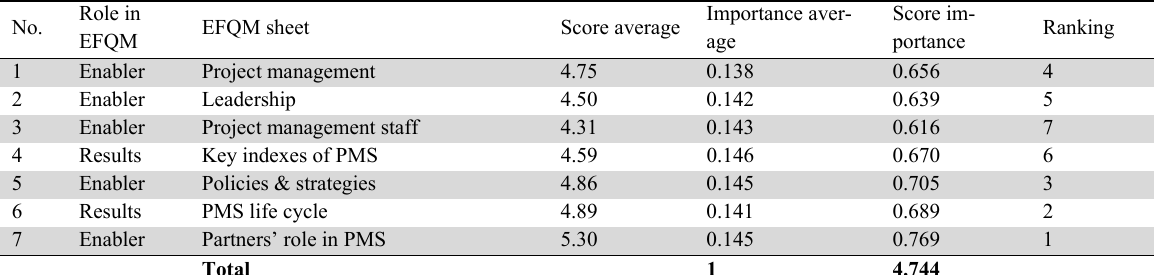
Organization status investigation after using quality